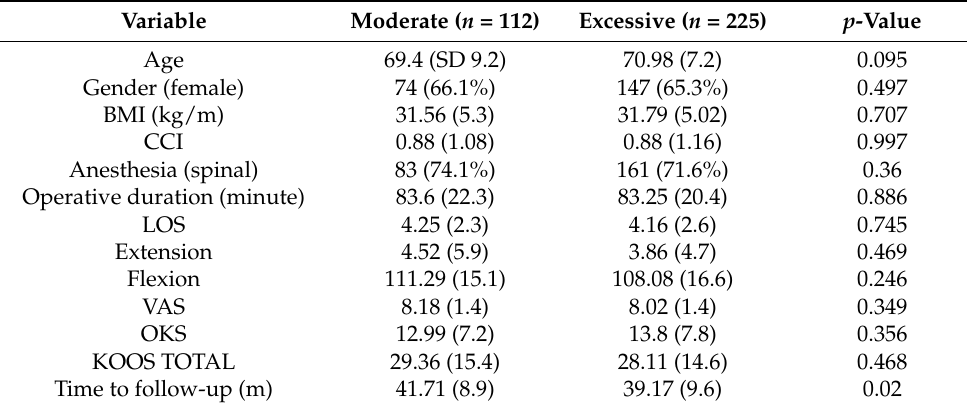
Table 1. Baseline characteristics, operative factors and patient-reported outcomes in the moderate versus excessive groups.